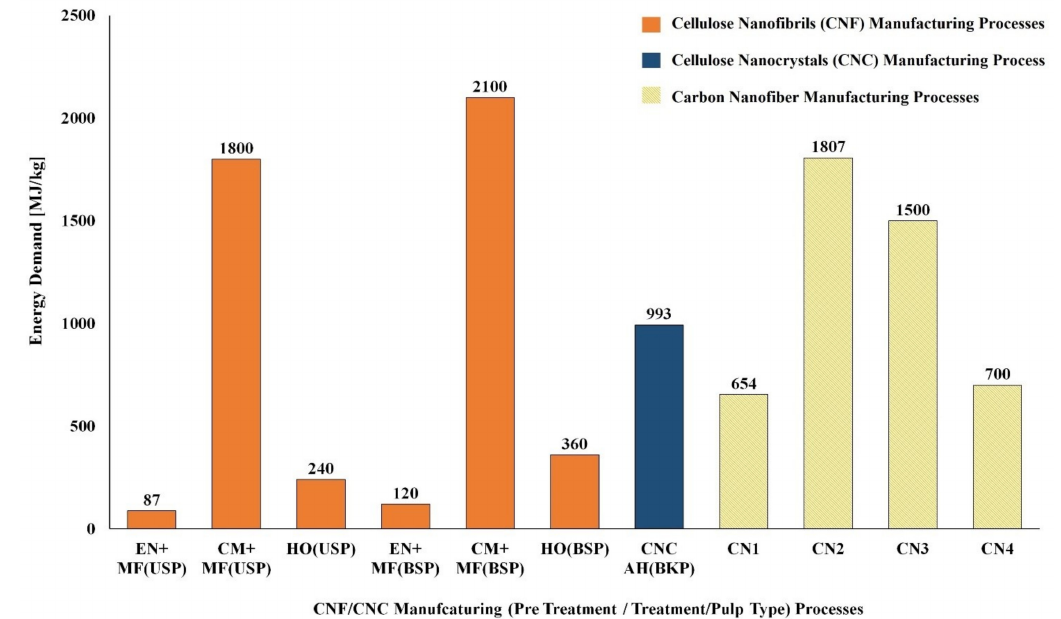
Figure 7. Comparison of the cumulative energy demand (CED) for CNF and CNC manufacturing pro- cesses with carbon nanofiber manufacturing processes. Note: AH—Acid hydrolysis, BKP-Bleached kraft pulp, BSP—Bleached sulfate pulp, CM—Carboxymethylation pretreatment, CN1—Carbon nanofiber from methane feedstock, CN2—Carbon nanofiber from methane feedstock with an H 2 carrier gas, CN3—Carbon nanofiber from ethylene feedstock with an H 2 carrier gas, CN4—Carbon nanofiber from benzene feedstock, CNC—Cellulose nanocrystals, EN—Enzymatic pretreatment,